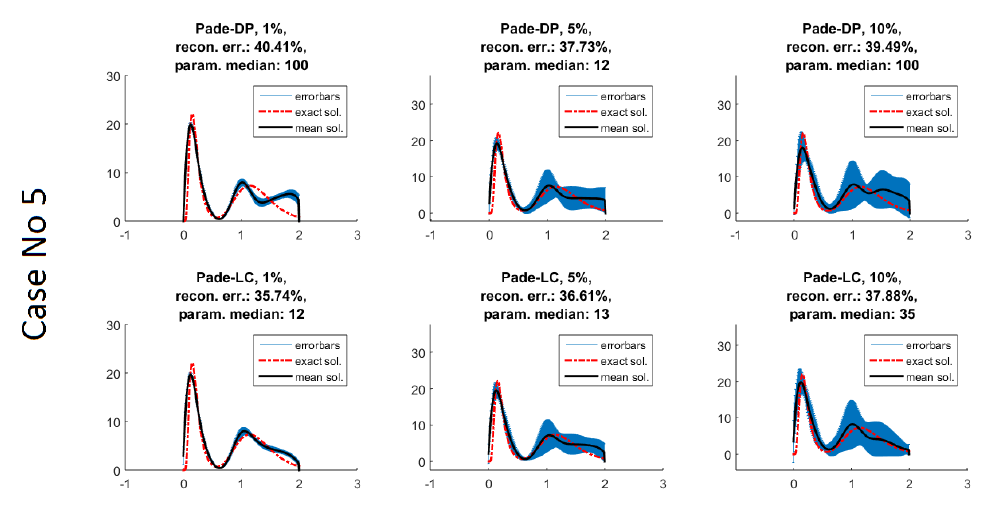
Figure 1. Reconstructions of volume size distributions [ µ m 3 /(cm 3 µ m)] ( y -axis) versus radius [ µ m] ( x -axis). Every set of (6) plots corresponds to Padé-DP solutions (top) and Padé-LC solutions (bottom) and to a specific case (2, 3 and 5) from Table 1, designated on the left side of the set. The title in each plot shows additionally the input error level, the mean reconstruction error and the median of the iteration numbers (param.) used by the 15 individual